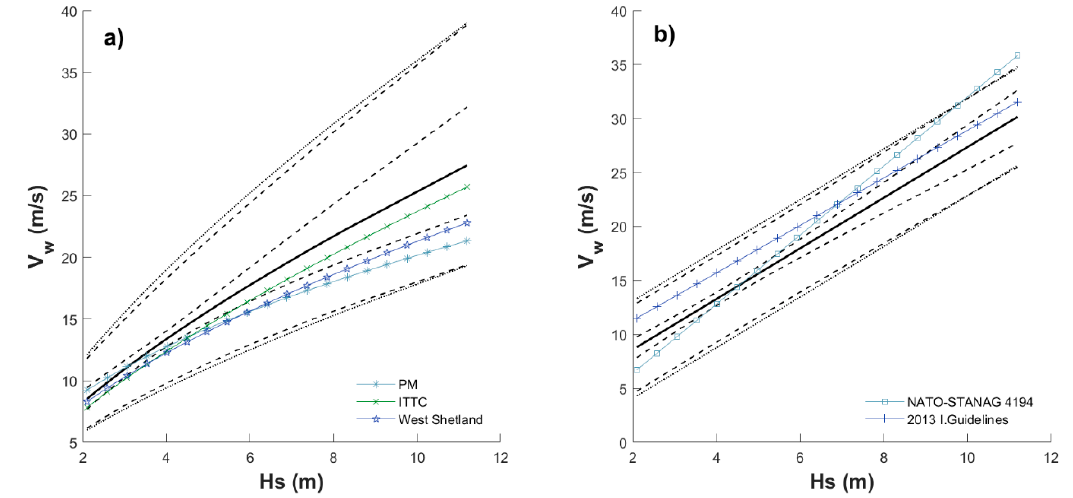
Figure 9. Exact and approximated 95% confidence intervals for October considering the T -yr values: regression ( a ) in logarithmic space and ( b ) in linear space. Legends indicate expressions referred in [28].